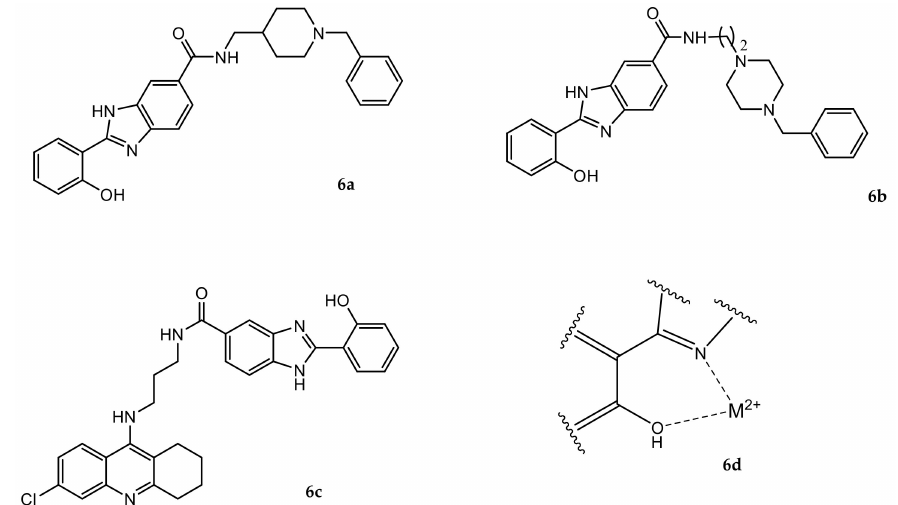
Figure 6. Structures of PP-BIM ( 6a ); PZ-BIM ( 6b ); and TAC-BIM ( 6c ); and their supposed chelation mechanism ( 6d ) [25].